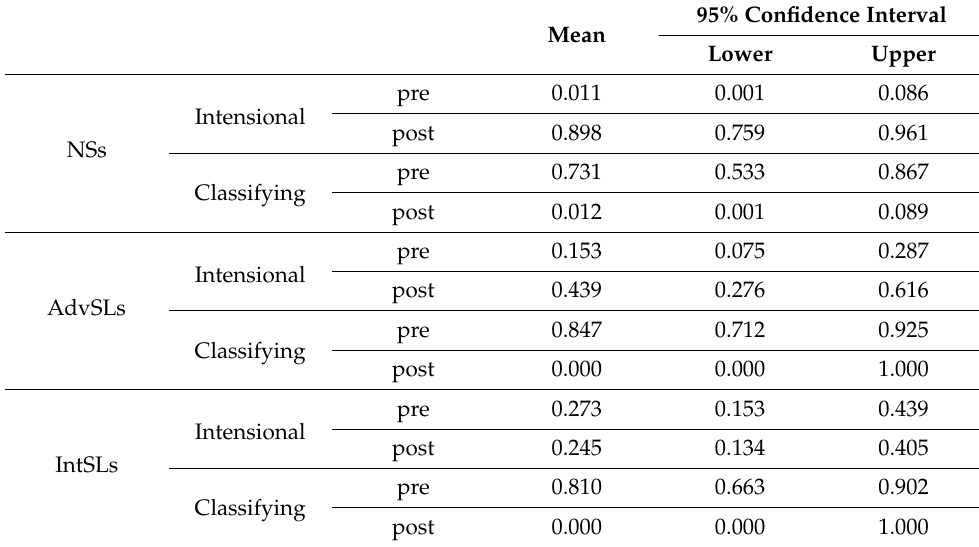
Figure 1. GJCT group results. PosN ClassAdj = grammatical postnominal classifying adjectives; *PreN ClassAdj = ungrammatical prenominal classifying adjective; PreN IntAdj = grammatical prenominal intensional adjective; *PosN IntAdj = ungrammatical postnominal intensional adjective. Table 4. Model estimates (probability of